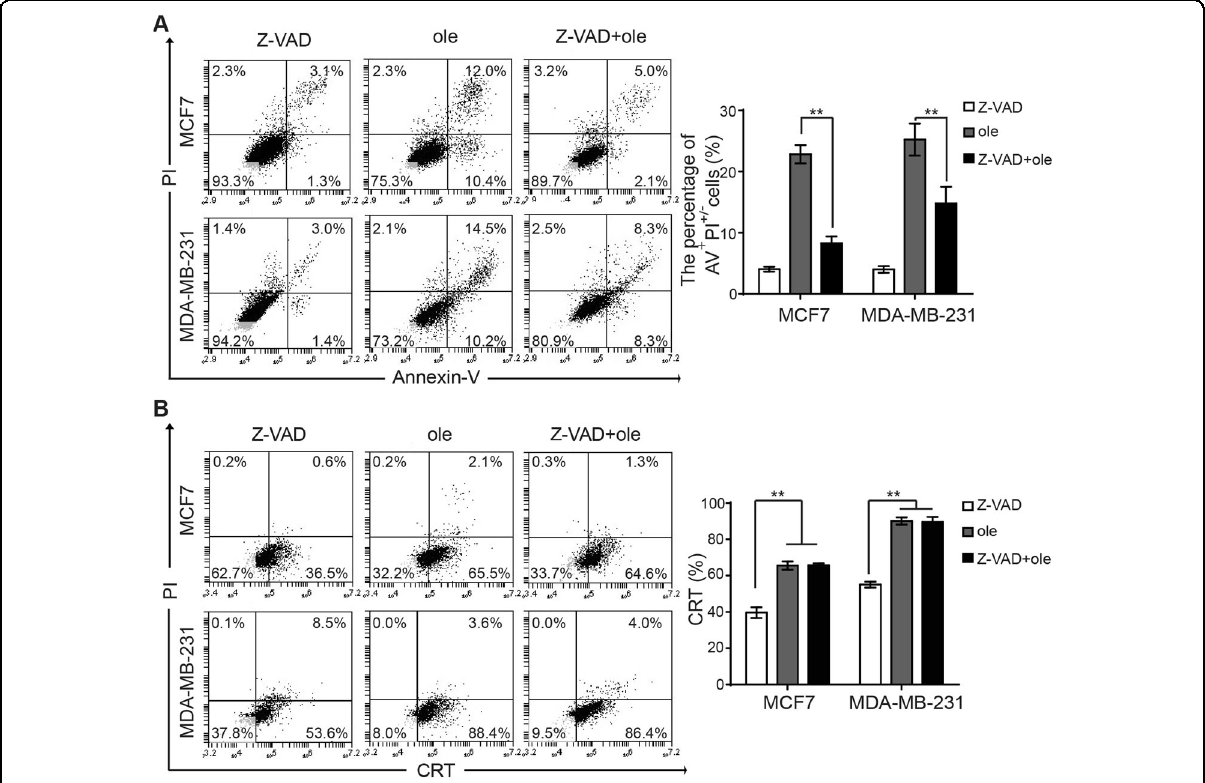
The apoptosis rate (Annexin-V + and PI + / − ) was shown as mean ± SD ( n = 3, ** p < 0.01 vs. control). B The CRT exposure on cell surface was detected by fl ow cytometry. The percentage of CRT + and PI - cells were shown as mean ± SD ( n = 3, ** p < 0.01 vs. control). AV, Annexin-V; ole,